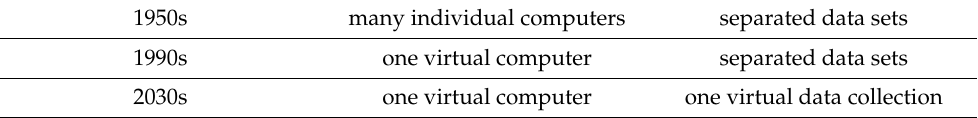
Table 1. This table indicates a rough categorization of phases of virtual integrations in IT